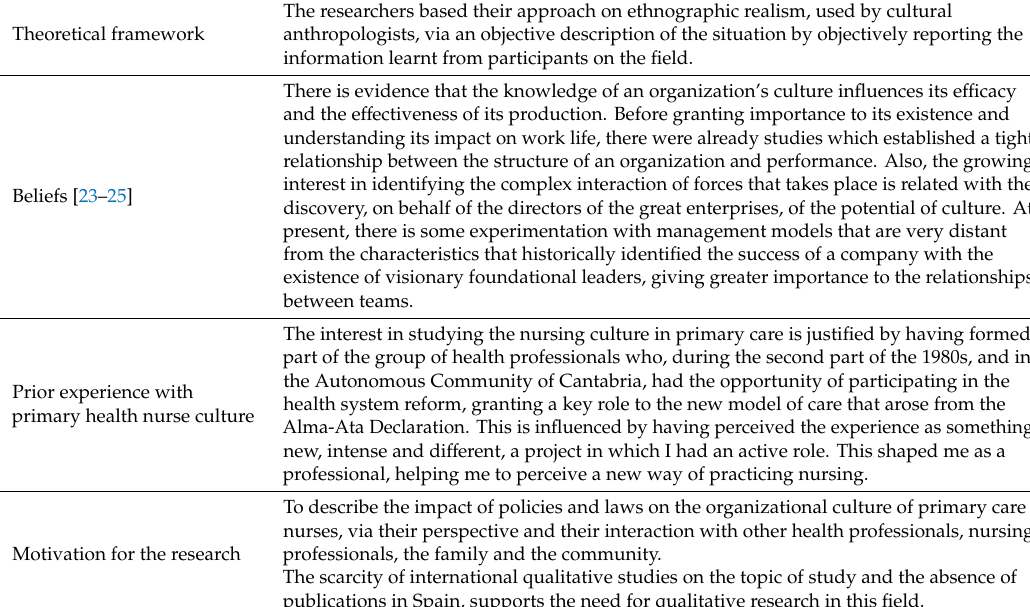
Table 1. The positioning of the